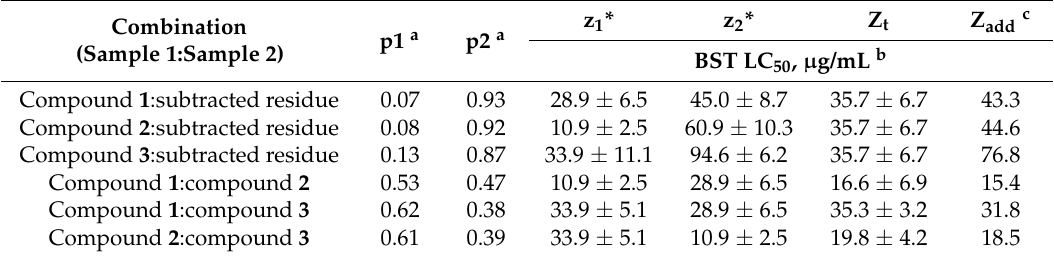
Table 2. Calculated and observed BST LC 50 and proportions of samples 1 and 2 in combination for six sample pairs prepared by